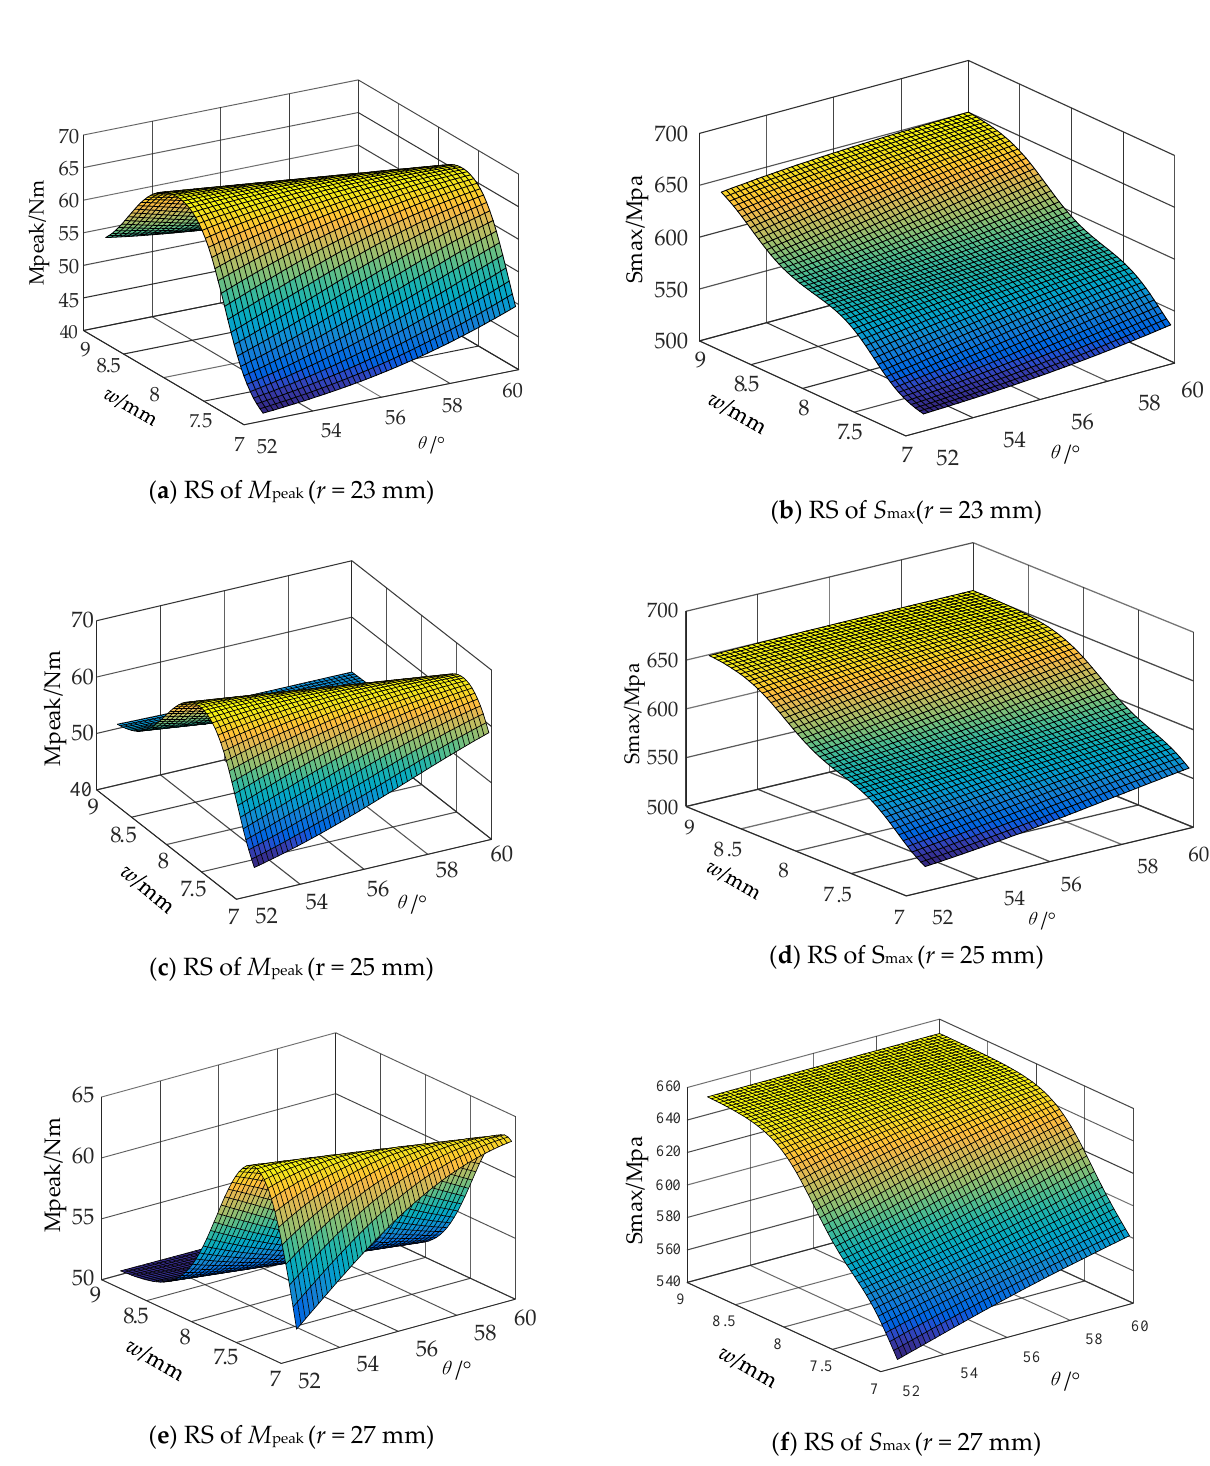
Figure 12. Response surfaces of the M peak and S max under different r value.